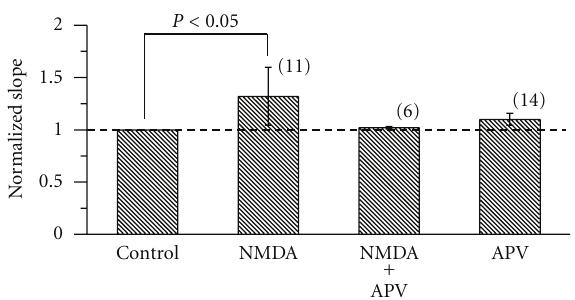
Figure 4: The e ff ect of DL-APV on the gain induced by NMDA in RA projection neurons. The f-I slopes of NMDA (20 μ M) alone, NMDA (20 μ M) +DL-APV (50 μ M), and DL-APV (50 μ M) alone were normalized to control, respectively. The broken line indicates the level of control (100%). The number of cells in each group is given in parentheses. P < 0 . 05 (One-way ANOVA followed by Sche ff e’s multiple comparison).